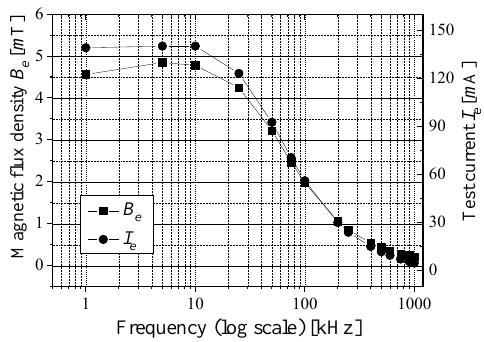
Figure 6. Calculated B e and measured I e w.r.t. the frequency for the test condition. (the ferrite core PM11 case).